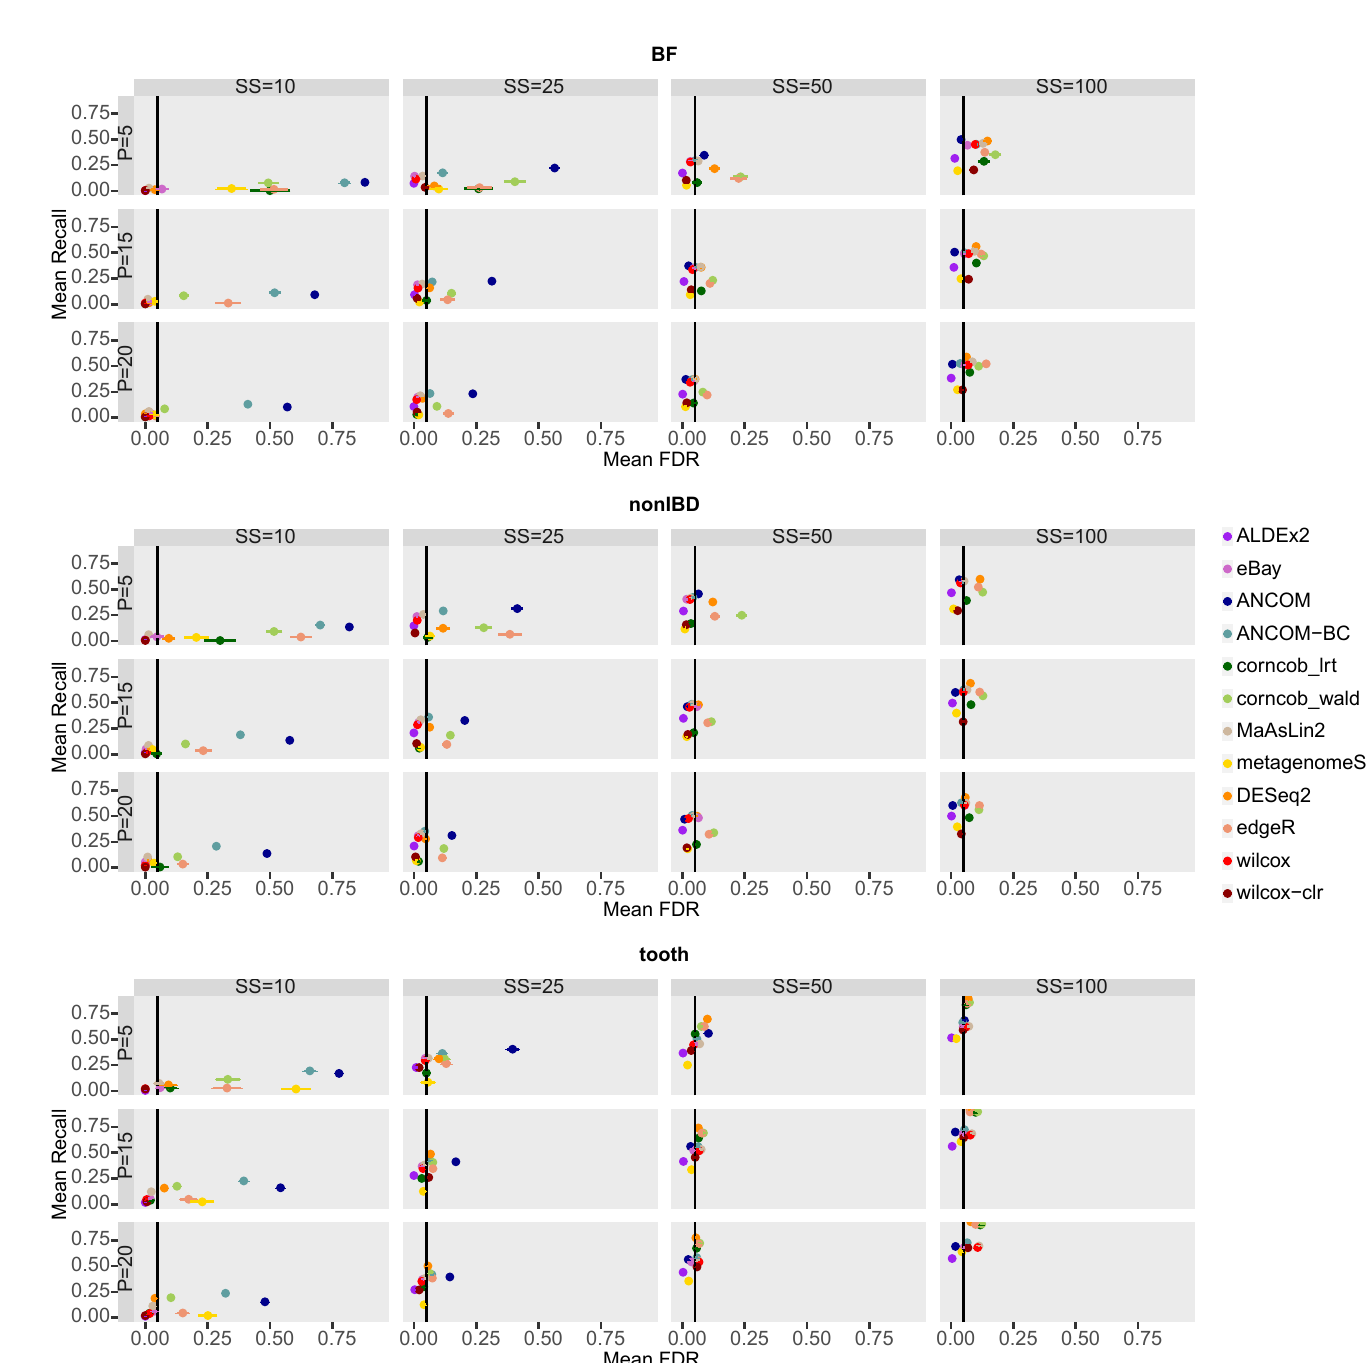
In Figs 31 and 32 in S1 File, the mean PR-curve and an example of a PR-curve in a single simulation are reported. ANCOM and ANCOM-BC show at SS = 10 and SS = 25 a curve that starts from low values, a different trend compared to the other methods.